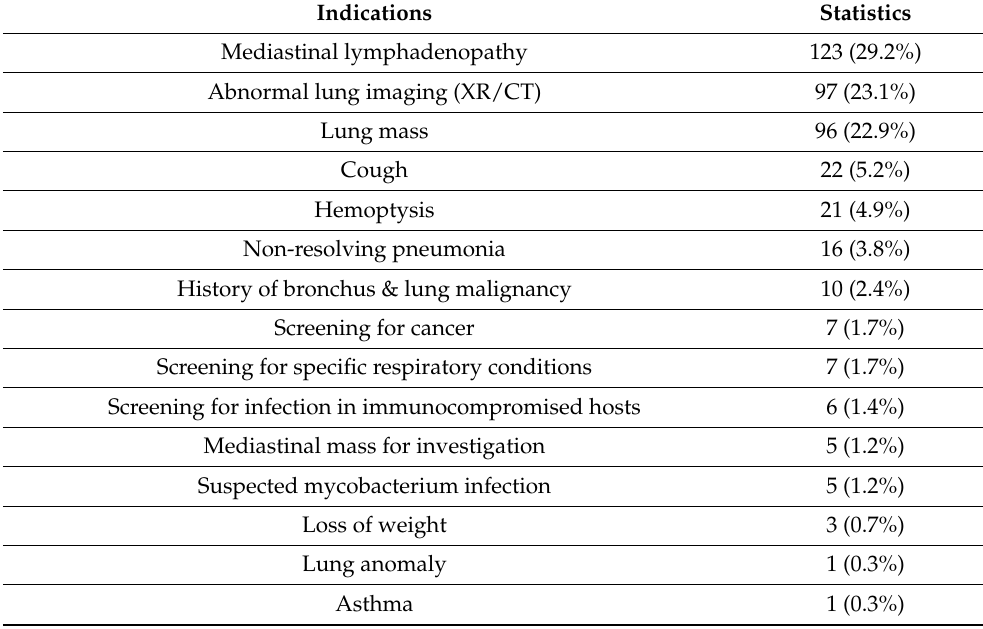
Table 2. Indications for either procedure (n = 420 cases).